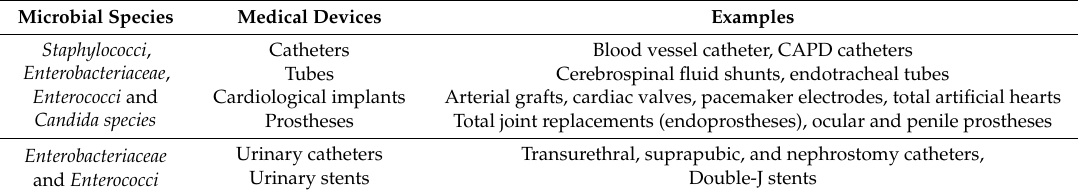
Figure 1. Phases of biofilm formation: ( A ) attachment; ( B ) expansion; ( C ) maturation; ( D ) dispersion. Table 1. Types of polymeric medical devices associated with nosocomial infections.